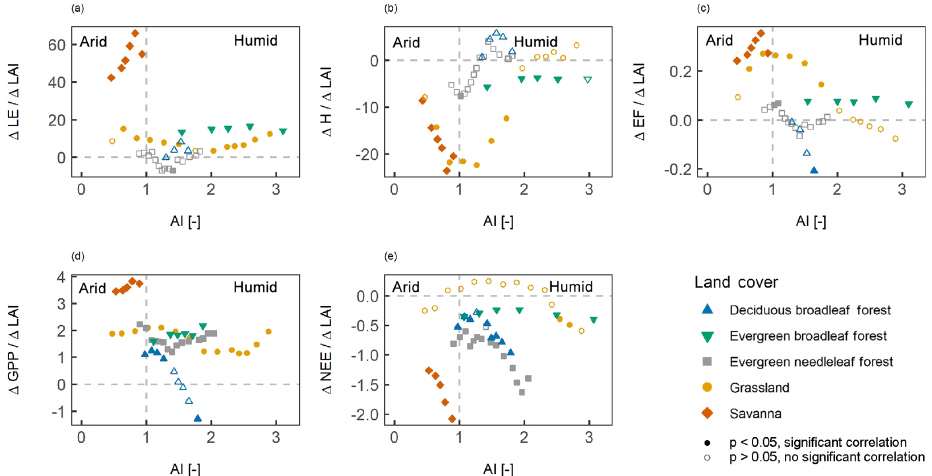
Figure 7. The effect of aridity on the relation between surface fluxes and the leaf area index (LAI). The slope of the correlation between the LAI and surface fluxes is shown for different aridity values for (a) the latent heat flux ( LE ), (b) the sensible heat flux ( H ), (c) the evaporative fraction (EF), (d) gross primary productivity (GPP), and (e) net ecosystem exchange (NEE). Each dot indicates the slope value for the 30 closest aridity values. The filled symbols indicate that the correlation was significant at p< 0 . 05, whereas the hollow symbols indicate a non-significant